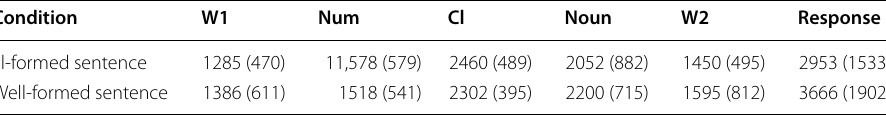
CL Non-ref N (Ill-formed) + +